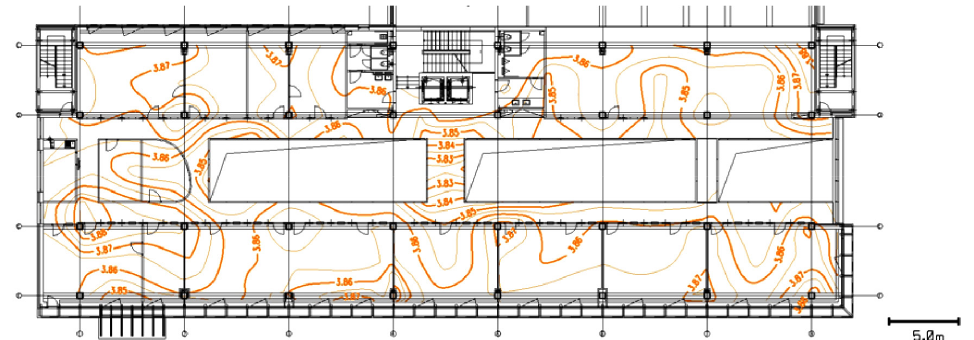
Figure 8. The contour height model of the 2 nd AGL floor